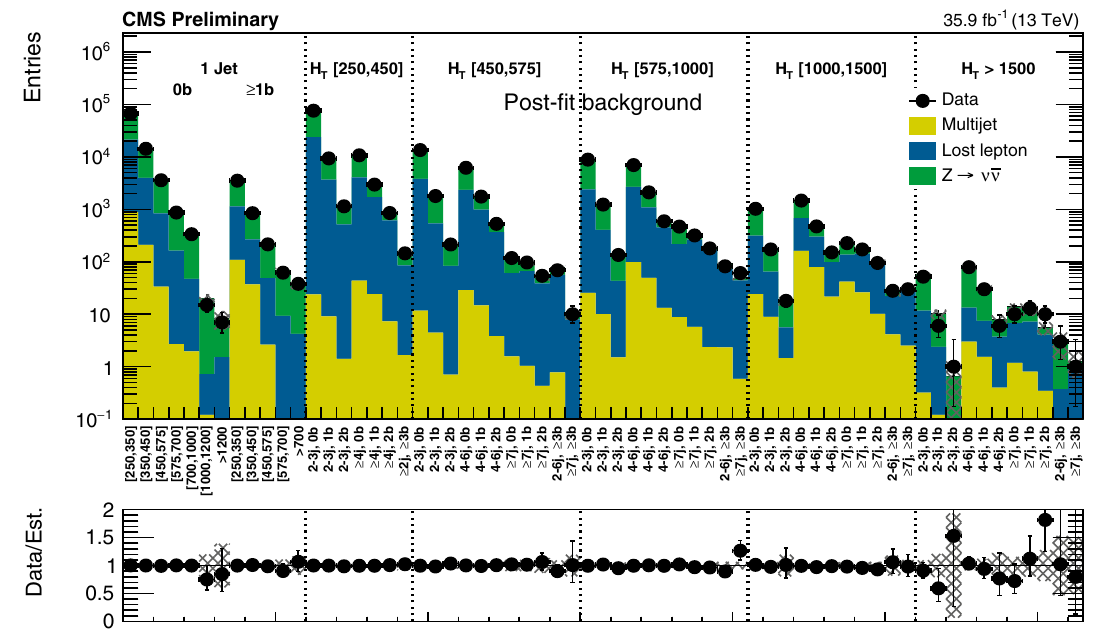
Fig. 11 Comparison of post-fit background prediction and observed data events in each topological region. Hatched bands represent the post-fit uncertainty in the background prediction. For the monojet, on